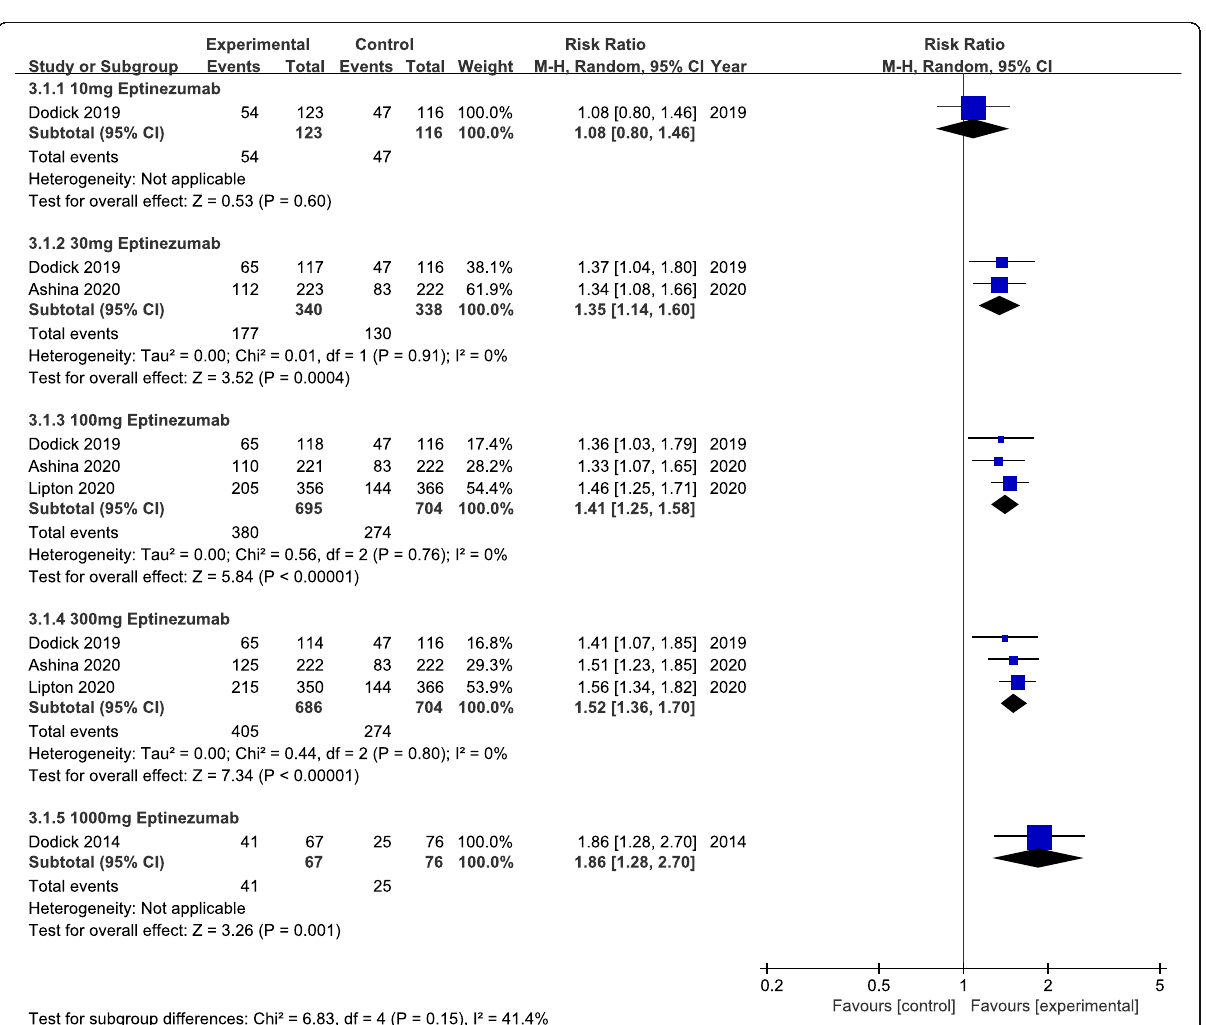
Fig. 4 The pooled risk ratio (RR) of 50% responder rate (defined as patients with a 50% reduction in migraine days from baseline) in different treatment doses compared with placebo, the diamond indicates the estimated RR with 95% confidence interval (CI) for the pooled